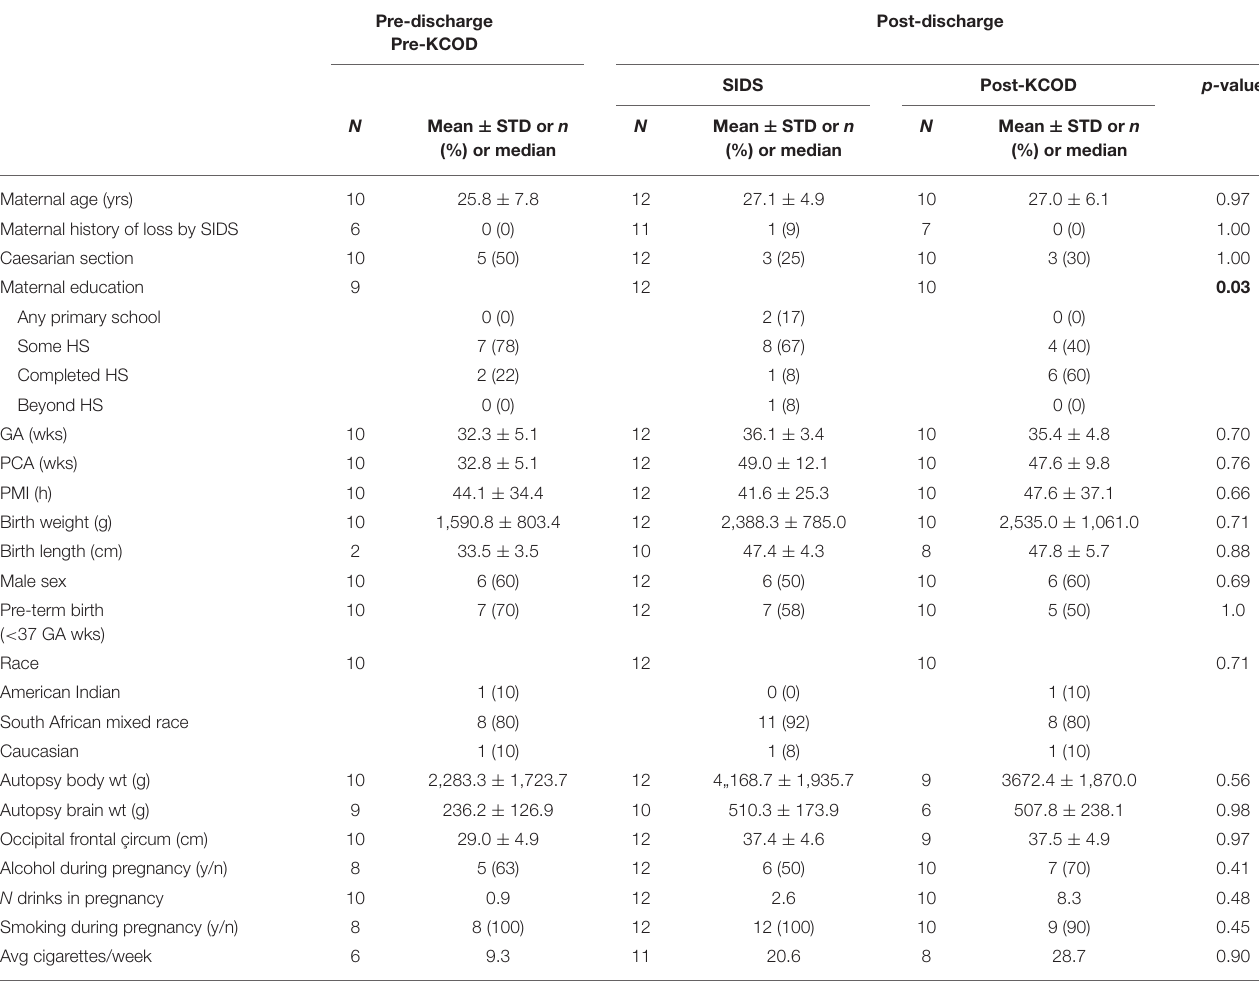
TABLE 2 | Selected demographic